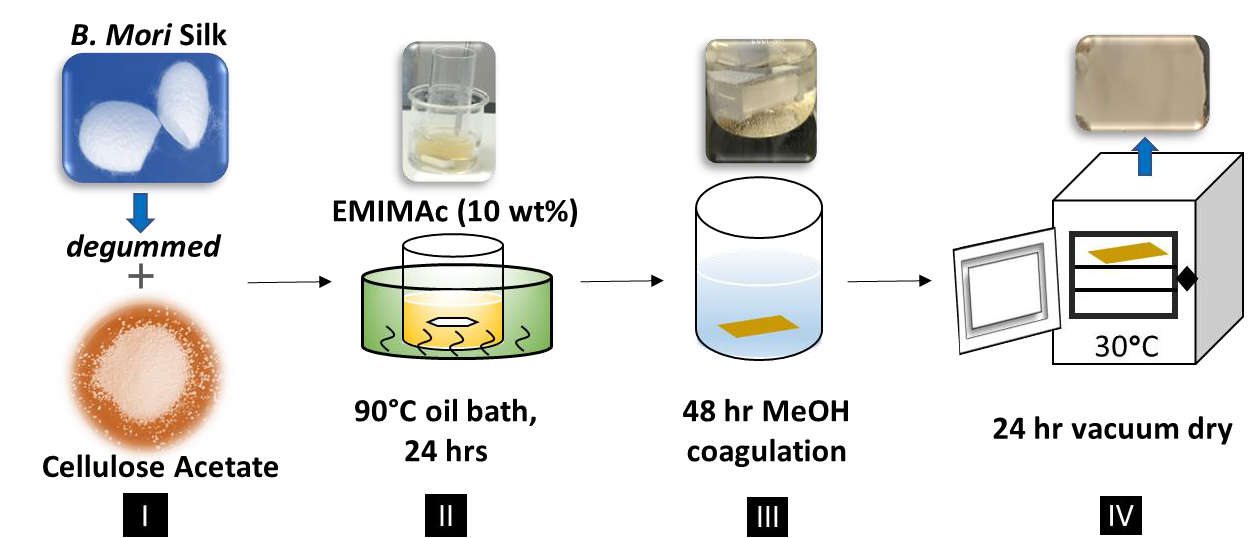
Figure 1. Procedure for the fabrication of silk-cellulose acetate films using EMIMAc as solvent.